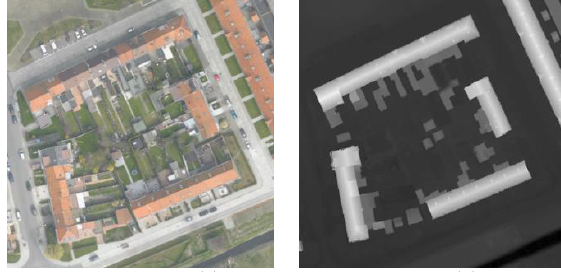
Figure 3. Test data: (a) optic image of test data , (b) DSM of test data